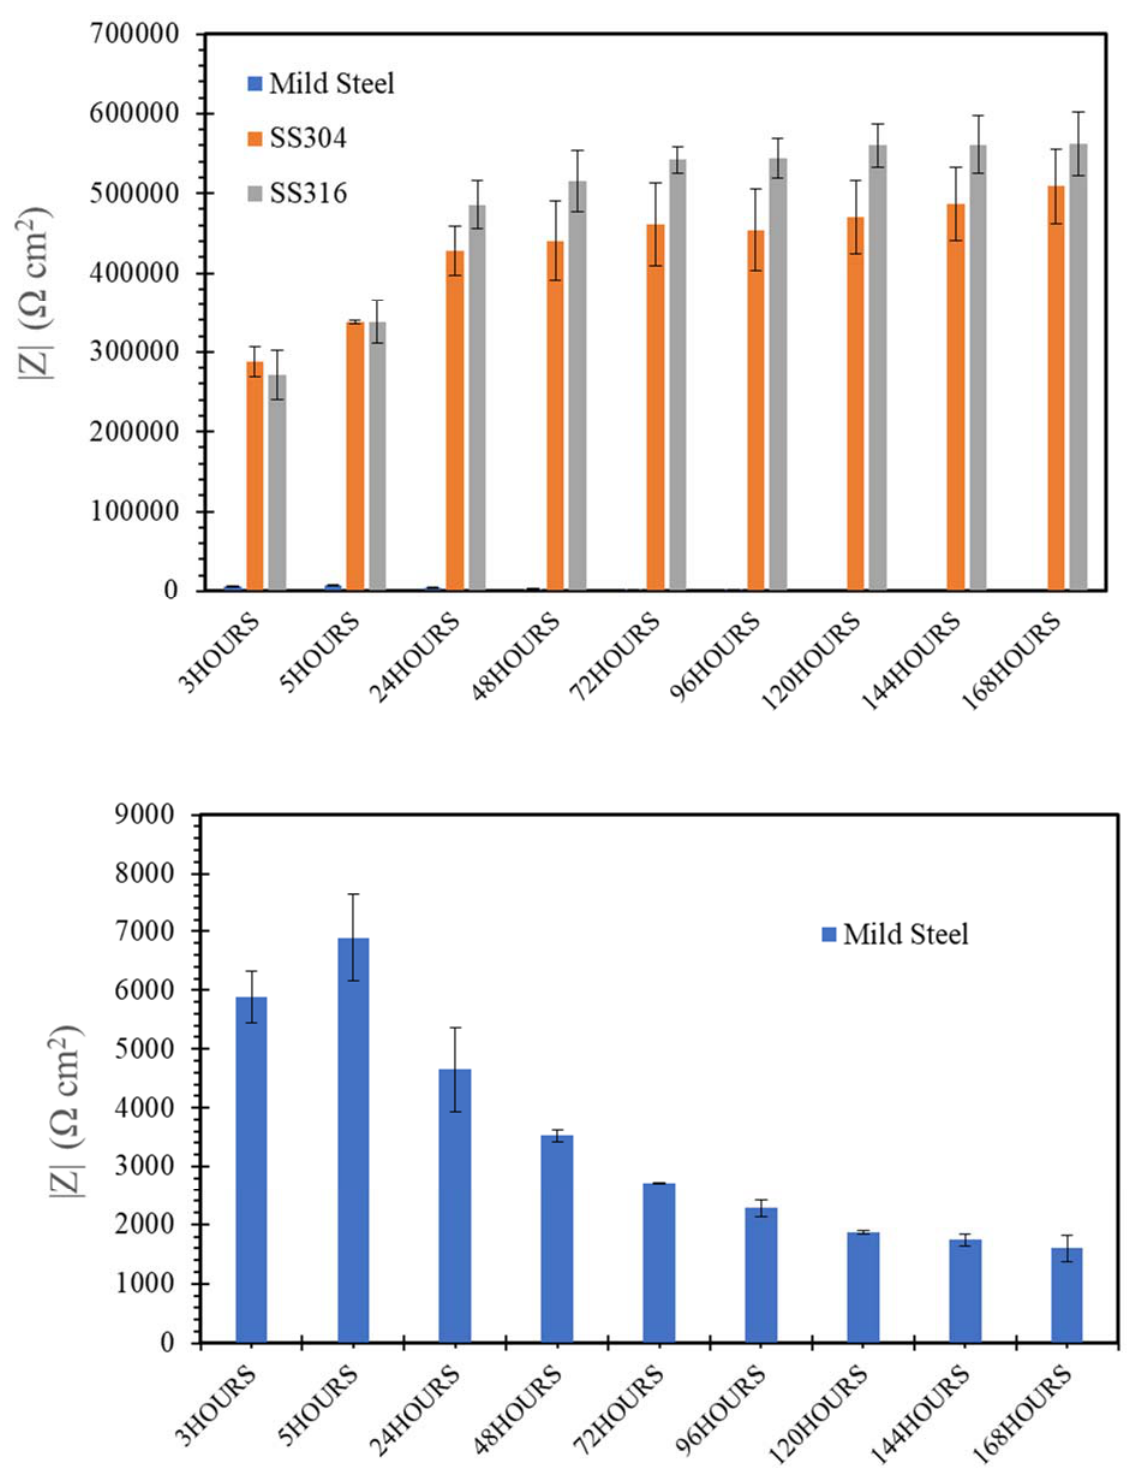
Figure 13. Evolution of impedance |Z| for of mild steel, SS304 and SS316 in SWSSHPC solution.